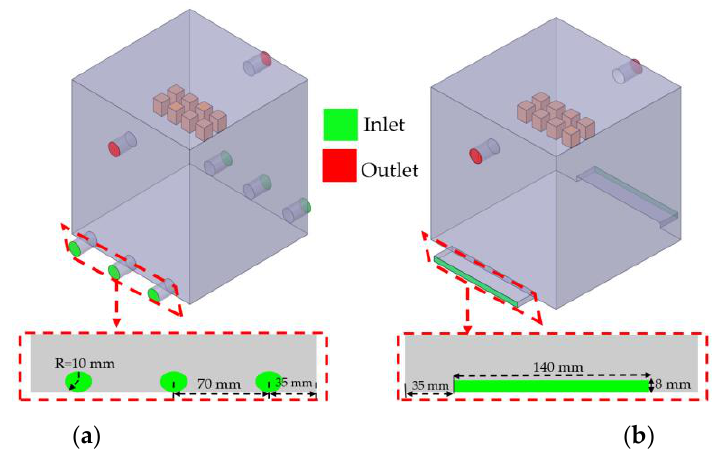
Figure 5. Fluid models of ( a ) circular inlet and ( b ) rectangular inlet.